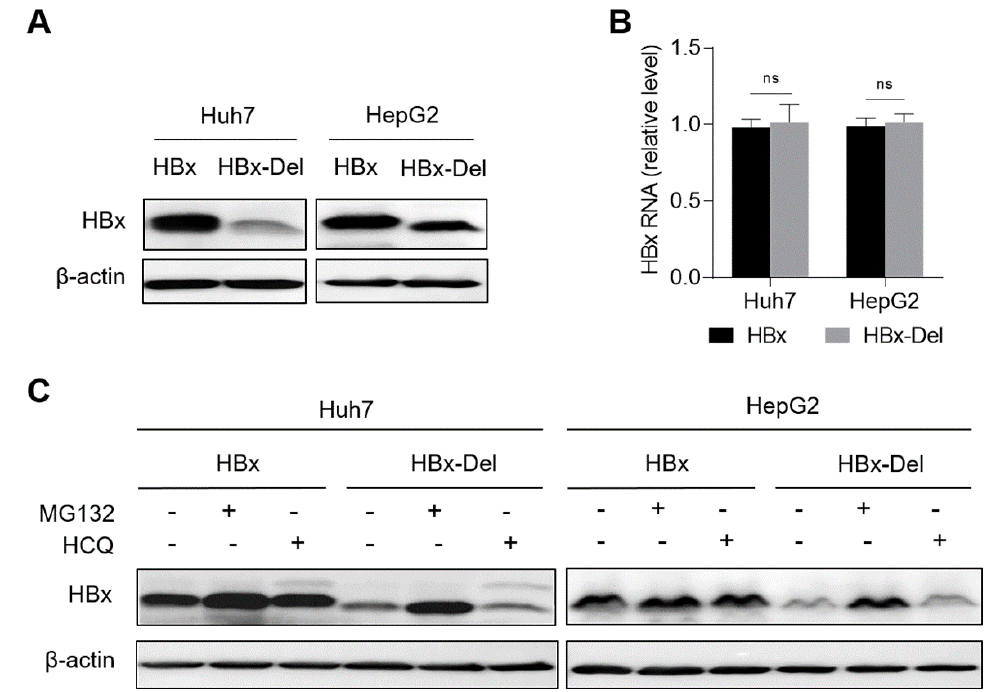
Figure 4. The effect of x128–133del on the HBx protein and mRNA levels. The pCDH-HBx-Del-3 × flag or pCDH-HBx-3 × flag plasmid was transfected into the Huh7 and HepG2 cells (5 × 10 5 cells/well in 6-well plate), and then the cells were harvested at 48 h after transfection. ( A ) The level of HBx protein was detected by Western blot. The β -actin protein was used as the internal control, and ( B ) the level of HBx mRNA was detected by RT-qPCR, and ACTB mRNA was used as the internal control. ( C ) The level of HBx protein was detected by Western blot in the Huh7 and HepG2 cells transfected with pCDH-HBx-3 × flag or pCDH-HBx-Del-3 × flag plasmid and treated with 15 µ M proteasome inhibitor MG132 for 6 h or 50 µ M lysosome inhibitor HCQ for 12 h at 48 h after transfection. The β -actin protein was used as the internal control. HBx-Del—x128–133del mutant HBx protein; ns—no statistical significance, Student’s t- test.